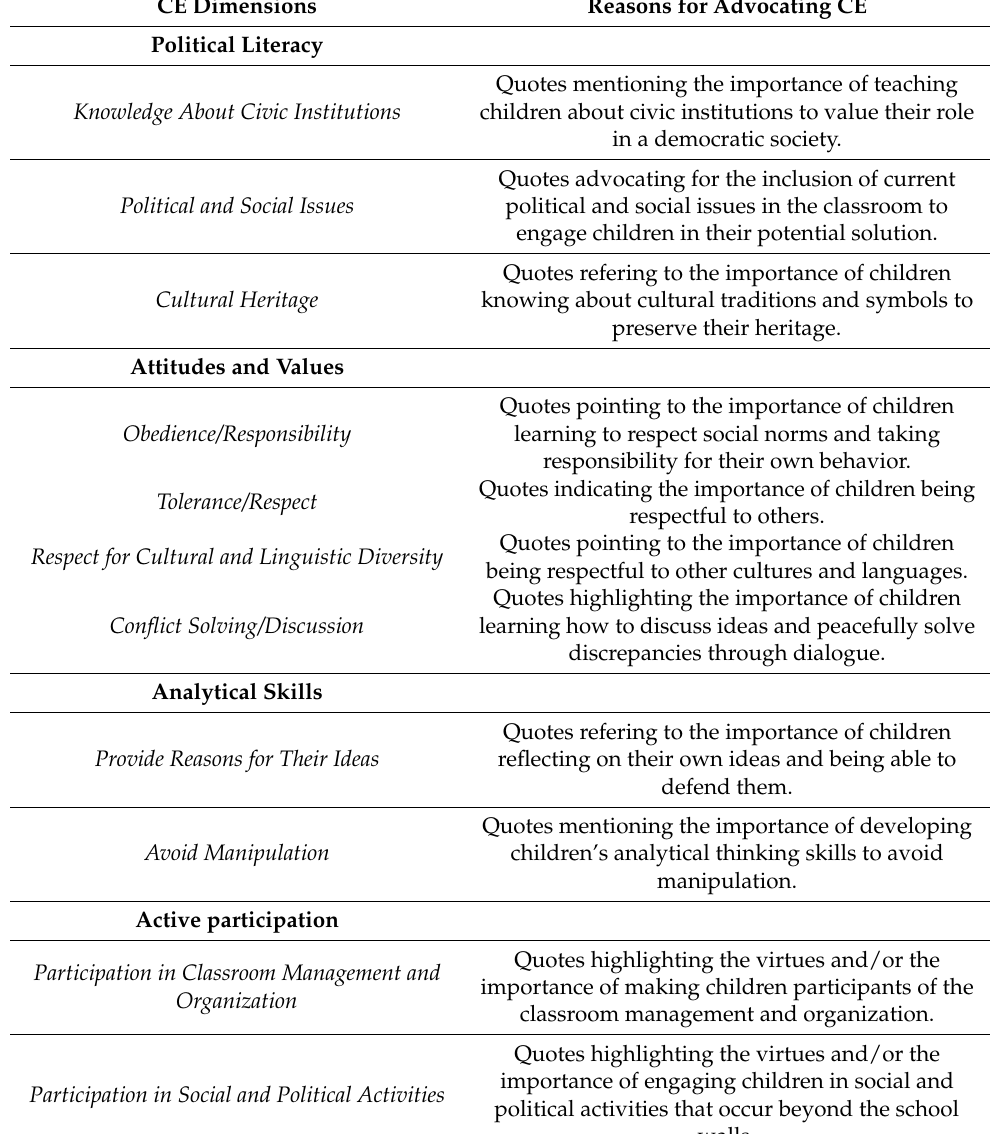
Table 5. CE dimensions and reasons for advocating